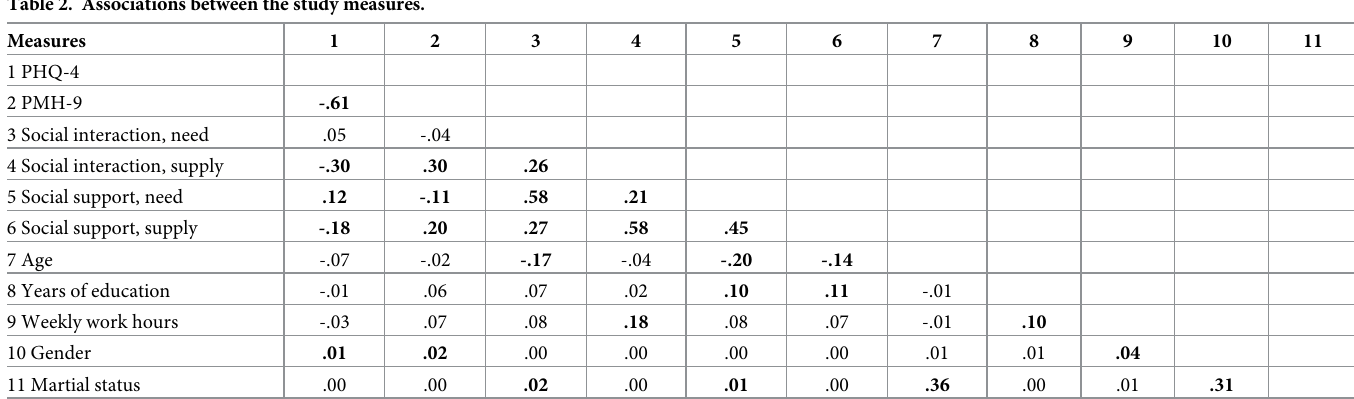
Table 2. Associations between the study measures.